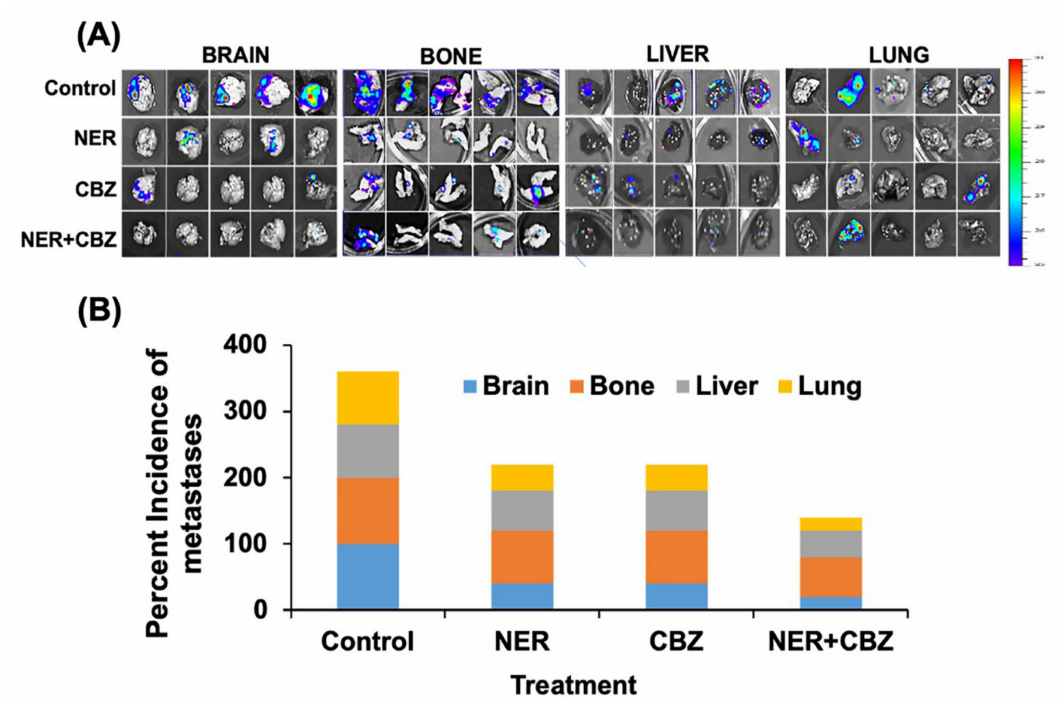
Figure 5. E ff ect of targeting the ERBB-c-MET axis on distant metastasis. ( A ) Post-therapy IVIS imaging of isolated metastatic organs including brain, bone, lung, and liver. Organs were harvested 3 weeks after the therapy with NER, CBZ, and their combination. ( B ) Stacked bar-graph to show the quantification of organ-specific metastasis using BLI, where the x-axis shows the percent incidences for metastasis in each organ including brain (blue), bone (orange), liver (gray), and lung (yellow), and the y-axis shows di ff erent treatment groups including control, NER, CBZ, and their